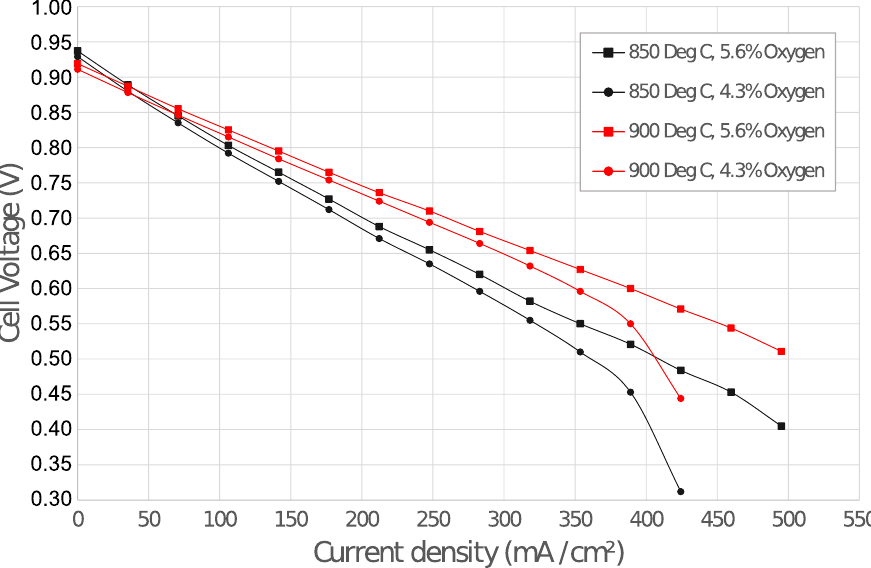
Figure 14. I-V curves for the two highest operating temperatures at the two lowest oxygen partial pressures. This shows that as the operating temperature of the cell is increased, the effect of decreasing partial pressure of oxygen is mitigated.